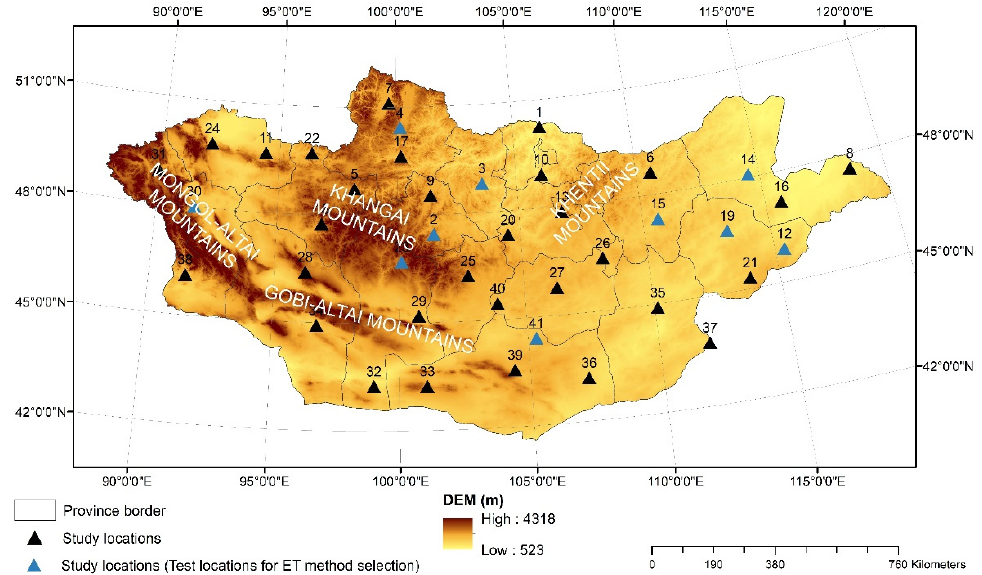
Figure 1. Locations of 41 weather stations (represented by the triangle symbol) on the digital elevation model (DEM) retrieved from the Shuttle Radar Topography Mission (SRTM) in Mongolia [20]. The ten blue triangles indicate the weather stations with a complete set of meteorological data used to compare FAO-56 PM with temperature-based equations.